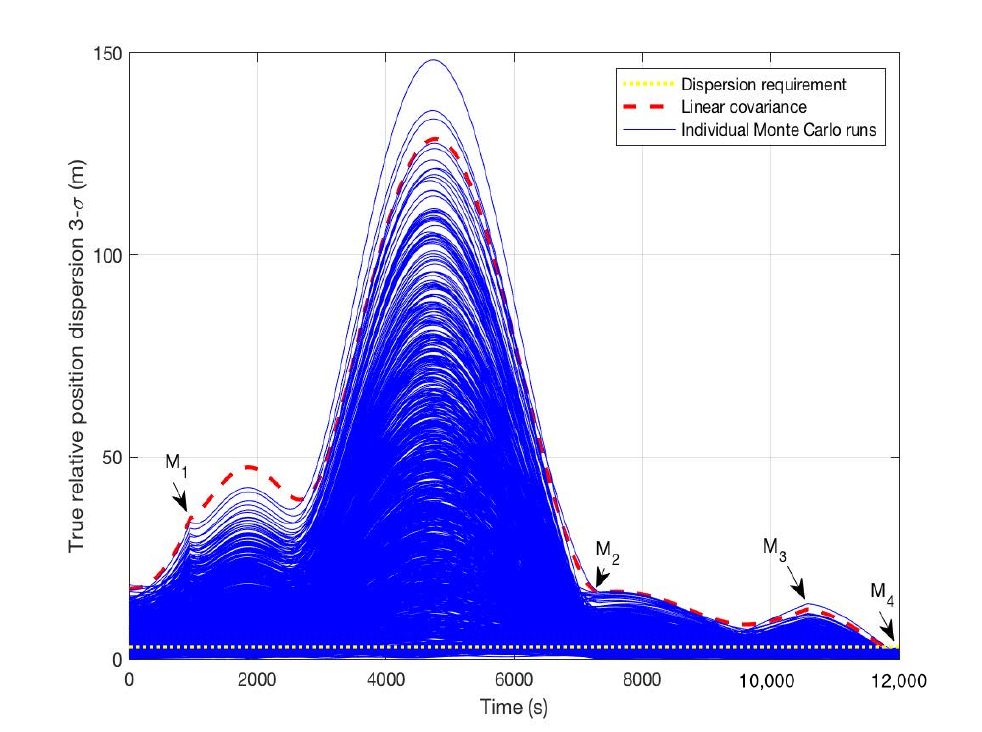
Figure 12. Monte Carlo analysis for high-cost system when t f = 12,000 s. Figures 13 and 14 show the in-plane and out-of-plane trajectories when t f = free, as well as the optimal maneuver